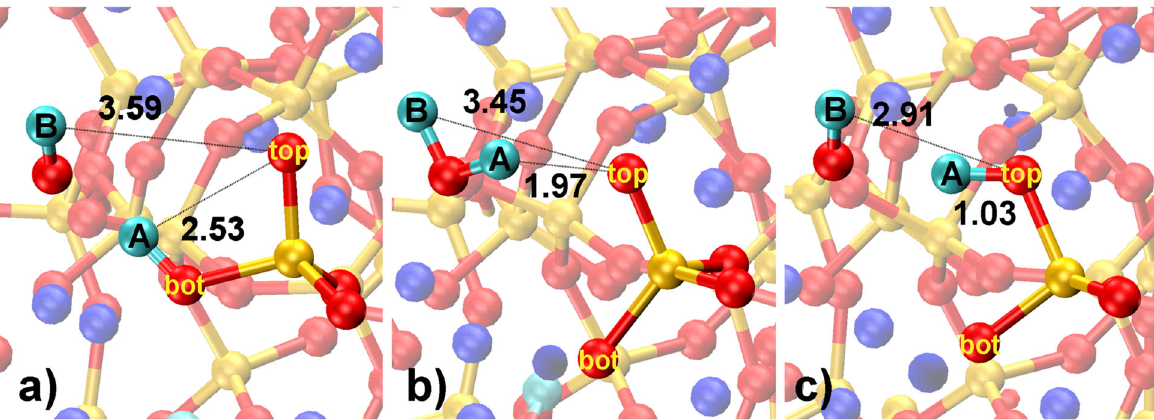
Fig. 4 Proton transfer mediated by a water molecule during the self-exchange silanol re-formation process. a A silanol group (Si – O bot H A ) with a nearby OH − , b two NBO − in same Si tetrahedron with a nearby water molecule, and c a silanol group (Si – O top H A ) with a nearby OH − , respectively.